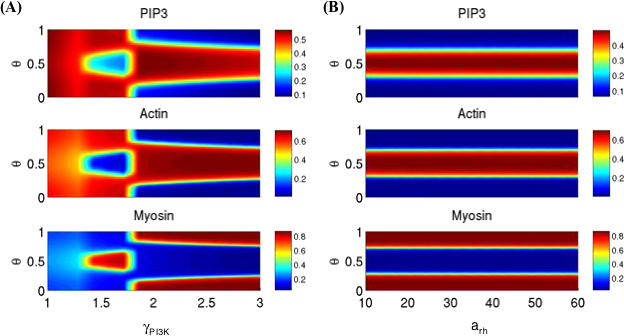
Sensitivity of Polarization to Parameter Values(A) As the ratio of PI3K binding sites to PI3K (γ
PI3K) decreases, the amount of PIP3 and actin bound on the membrane increases.(B) Polarization is insensitive to the association rate constant of RhoA (aRh).